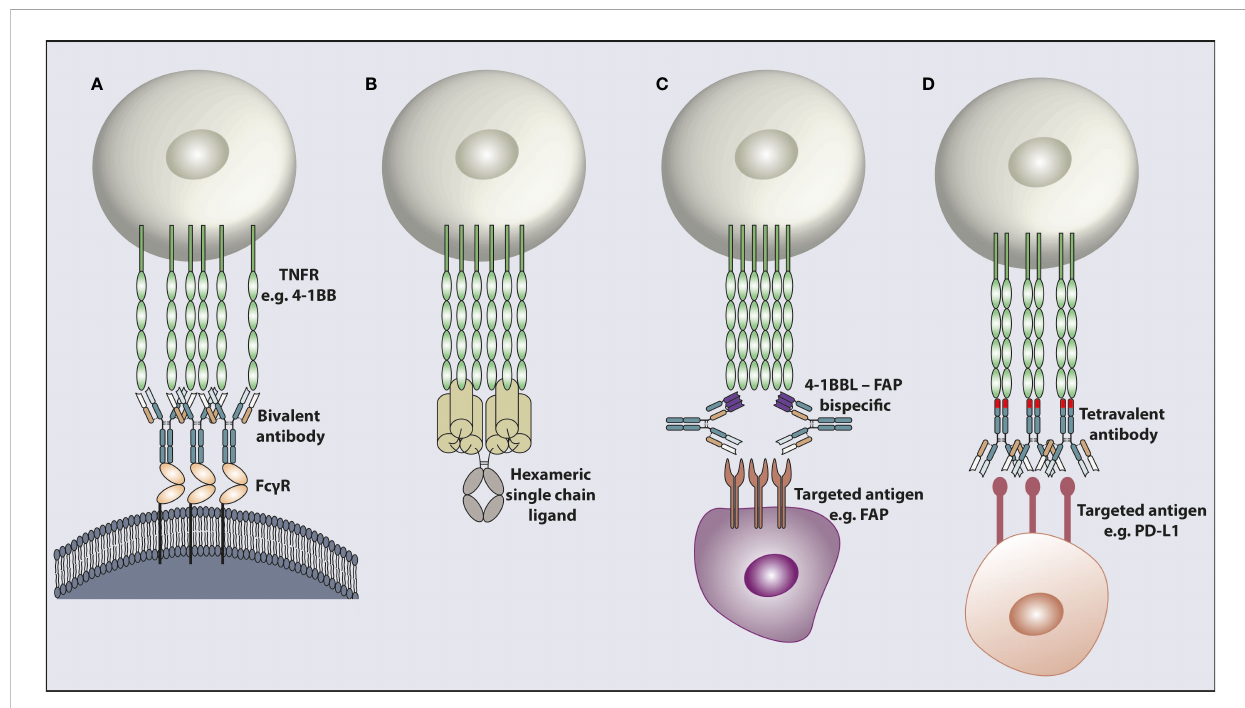
FIGURE 2 Modalities for targeting and activating TNFR. TNFR cross-linking achieved by different mechanisms. (A) Engagement with Fc g R enables bivalent mAb cross-linking leading to target receptor clustering. (B) A recombinant hexameric single chain ligand inducing receptor clustering. The hexameric ligand structure is composed of a full Fc domain and six TNFSF ligand ECDs. (C) An antibody shaped bispeci fi c molecule with one antigen binding arm targeting a TNFR e.g. 4-1BB and the other arm targeting a receptor e.g. FAP in the tumor microenvironment. (D) A bispeci fi c molecule in a tetravalent format with two antigen binding arms targeting one receptor e.g. PD-L1 and the other two antigen binding arms in the opposite end of the molecule binding the TNFR e.g. 4-1BB, to induce receptor clustering. The 4-1BB binding domains inserted into the CH3 domain are indicated as a different color in the CH3 domain. TNFR; tumor necrosis factor receptor, Fc g R; Fc gamma receptor, 4-1BBL; 4-1BB ligand, FAP; fi broblast activation protein, PD-L1; programmed death ligand